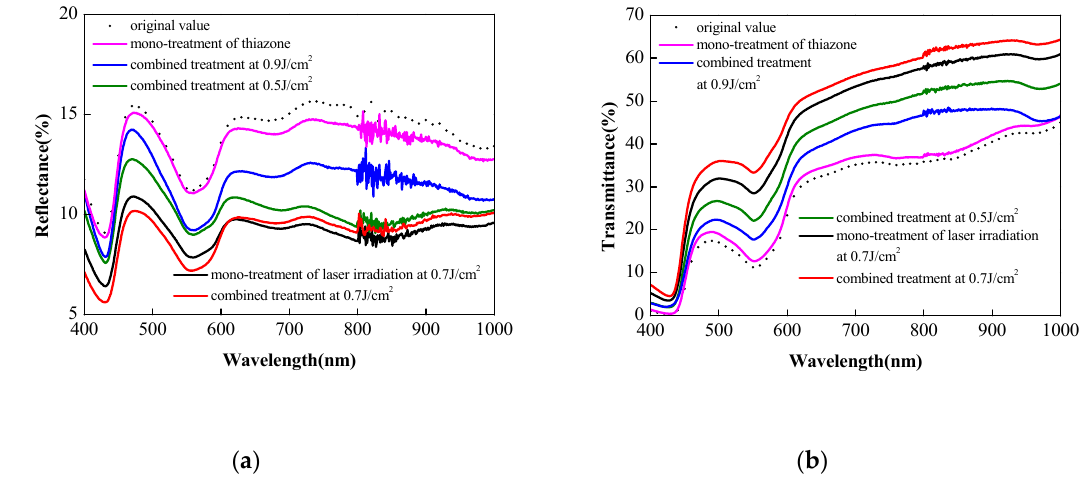
Figure 5. Typical reflectance ( a ) and transmittance ( b ) spectra of in vitro rat skin with different treatment in 60 min.